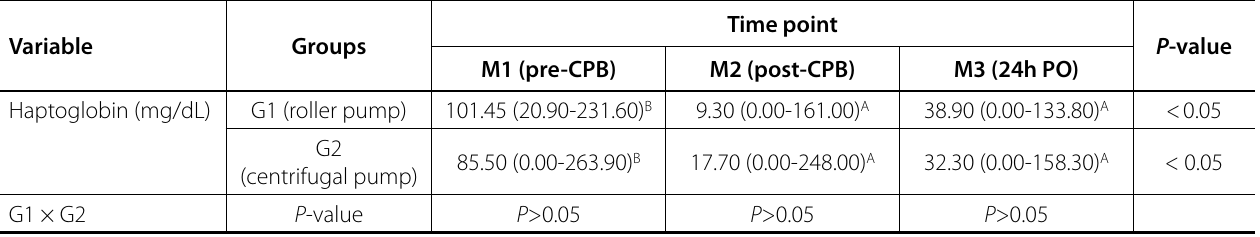
Figure 1 illustrates the results of LDH measurement. Significant ( P <0.05) differences between time points were observed in LDH levels, where M1 = M2 < M3 in G1 and M1 < M2